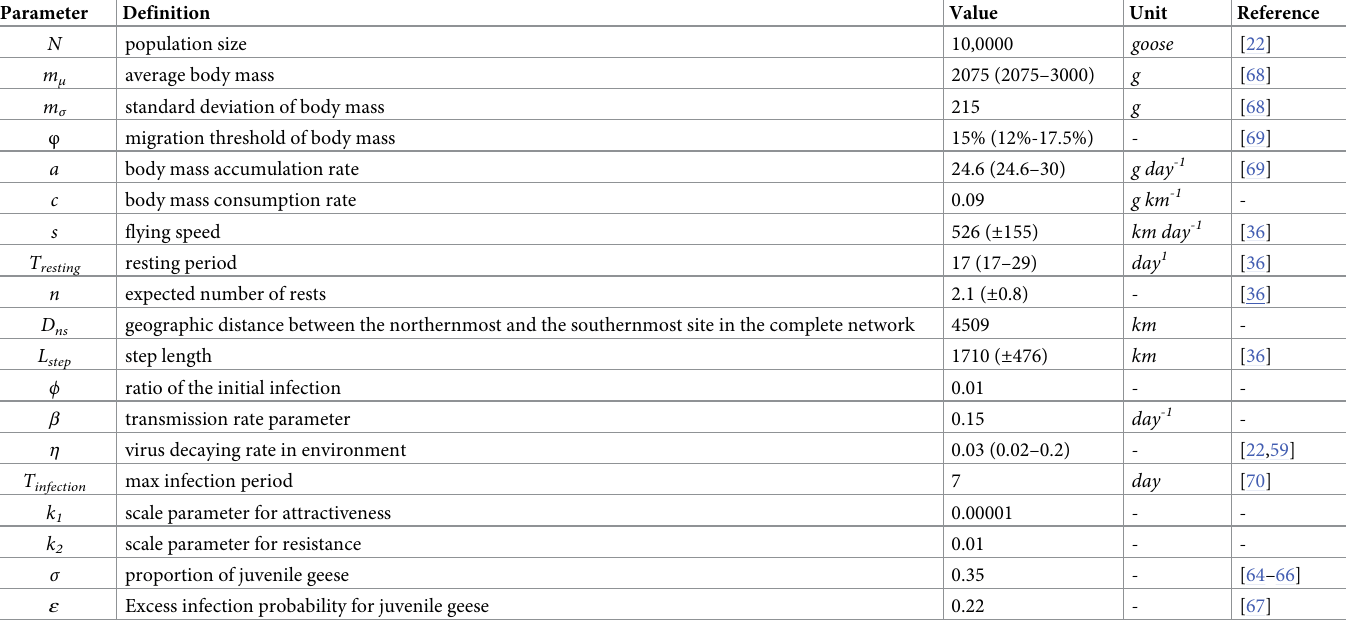
Table 1. Parameters in the agent-based model, with their abbreviation, definition, value, unit, and